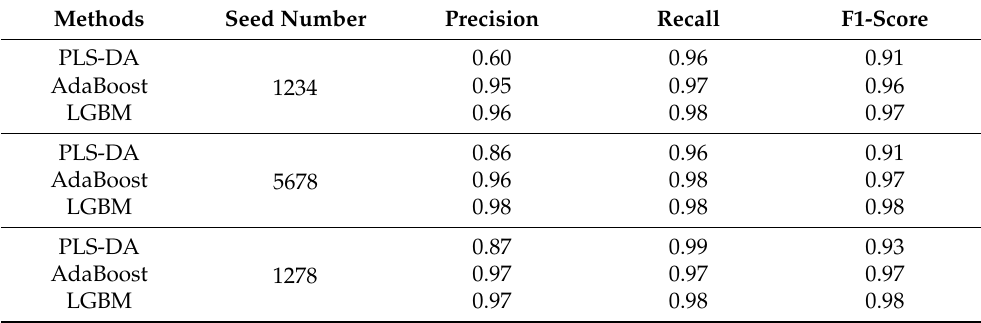
Table 5. The precision, recall, and F1-score values of the established models for MN properties.